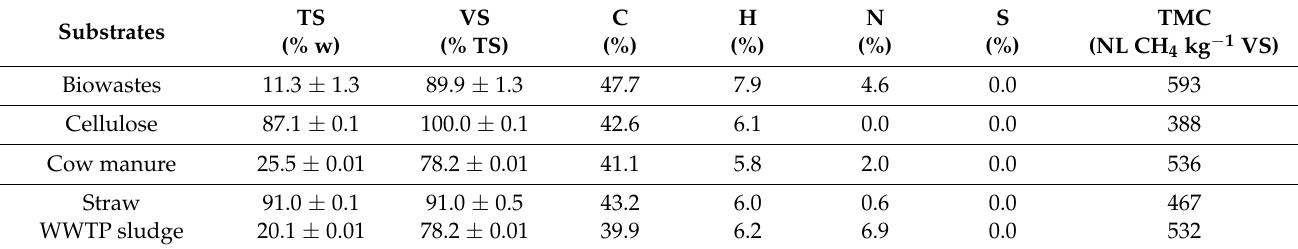
Table 2. Substrate composition and Theoretical Methane Potential (TMC). CHNS standard deviation were inferior of 0.2%. TS VS C Substrates (% w) (% TS) (%) Biowastes 11.3 ± 1.3 Cellulose Cow manure 25.5 ± 0.01 Straw 91.0 ± 0.1 WWTP sludge 20.1 ±